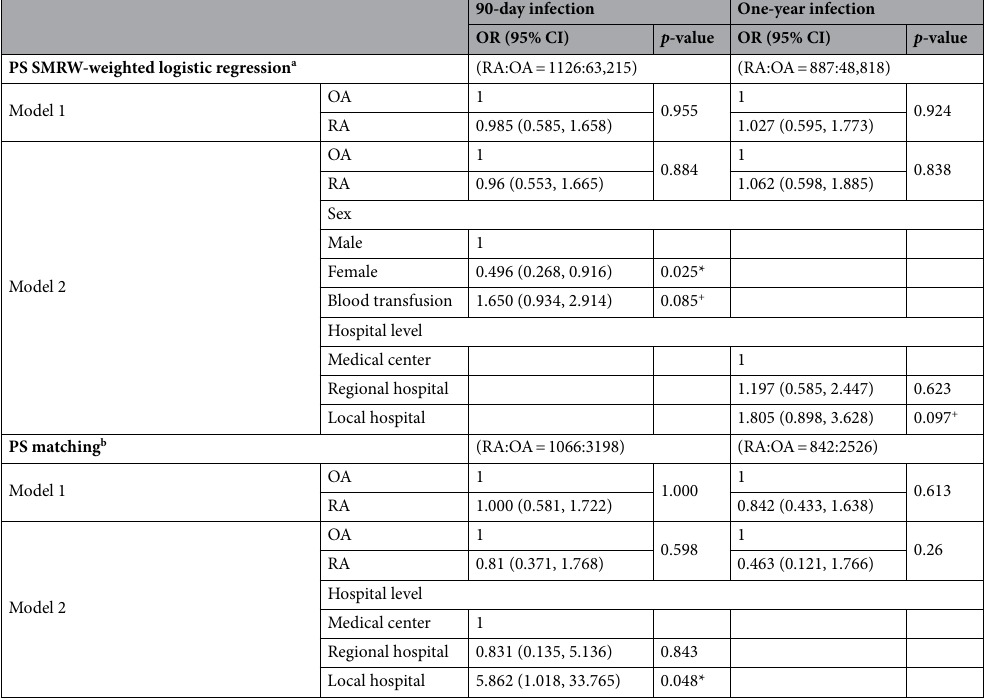
Table 3. The adjusted odds ratio of perioperative infection for patients with RA. CI, confidence interval; OA, osteoarthritis; OR, odds ratio; PS, propensity score; RA, rheumatoid arthritis. Model 1: correction with diagnosis (RA/OA); Model 2: correction with diagnosis (RA/OA), sex, age, hypertension, hyperlipidemia, diabetes mellitus, length of stay, blood transfusion, and hospital level. * p -value < 0.05; + 0.05 < p -Value < 0.1 a Weighted logistic regression for original data, using standardized mortality ratio weighting (SMRW). b PS matching with conditional logistic